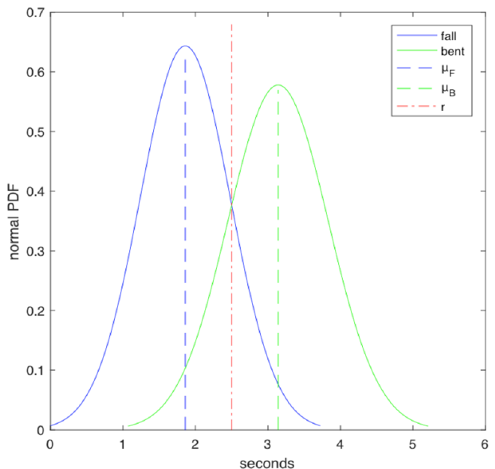
Figure 1. Normal probability distribution function (PDF) of t F (fall values) and t B (lean over values).